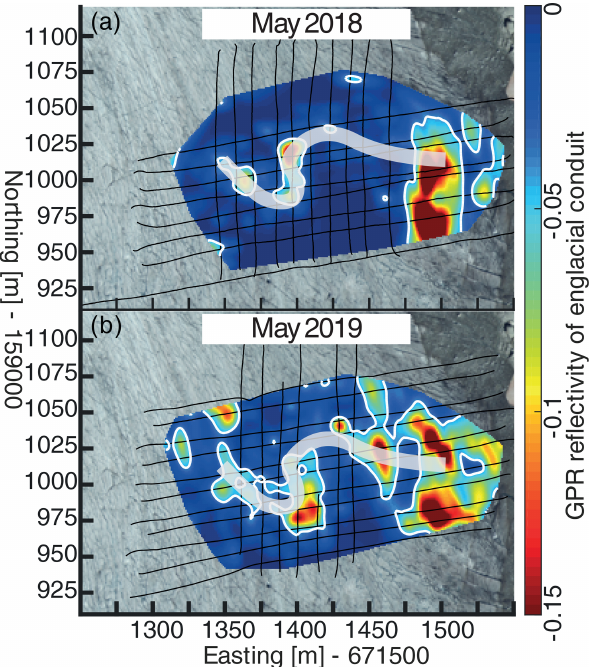
Figure 11. Winter GPR reflectivity from the top of the englacial channel reflection plotted between 0 and − 0 . 15 reflectivity values, highlighting remnants of the englacial conduit network that exist during the winter months. The grey line represents the summer englacial conduit shape. The black grid lines represent the GPR ac- quisition profiles acquired for each month. The white contour rep- resents the reflectivity at − 0 .